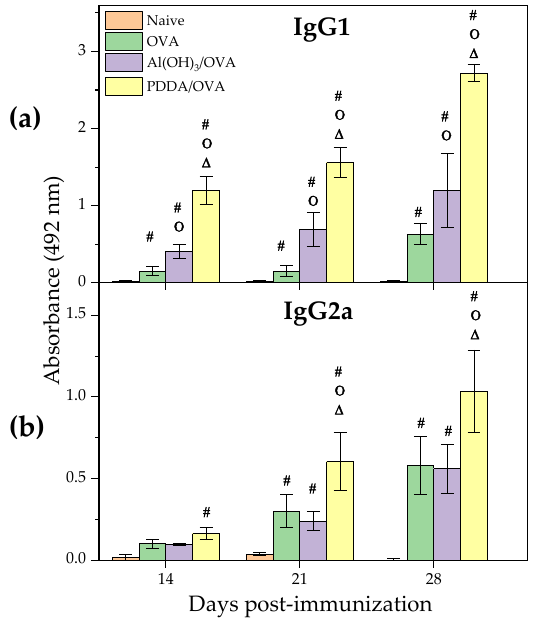
Figure 7. Humoral responses induced by OVA, Al (OH) 3 / OVA, or PDDA / OVA NPs at concentrations given in Table 1. Mean absorbance at 492 nm ± standard deviation related to anti-OVA IgG1 and IgG2a antibodies production was determined over time after immunization of BALB / c mice from sera collected on days 14 and 21 post-immunization (primary response) or on day 28 (secondary response). The primary IgG1 production was determined at 1 / 256 serum dilution whereas the secondary one was obtained at 1 / 16348 dilution. The primary IgG2a production was determined at 1 / 8 serum dilution whereas the secondary one was obtained at 1 / 128 dilution. p < 0.05 compared to naive group (#), p < 0.05 compared to OVA group (o), p < 0.05 compared to Al(OH) 3 / OVA group ( ∆).